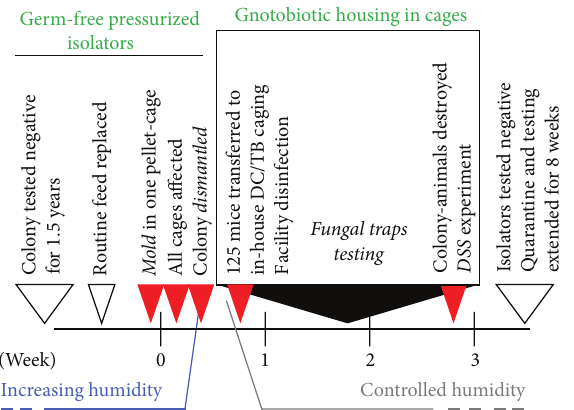
Figure 2: Timeline of A. sydowii contamination of germ-free mouse facility and implementation of germ-free in-house cage- based housing system to monitor 125 animals and conduct DSS colitis